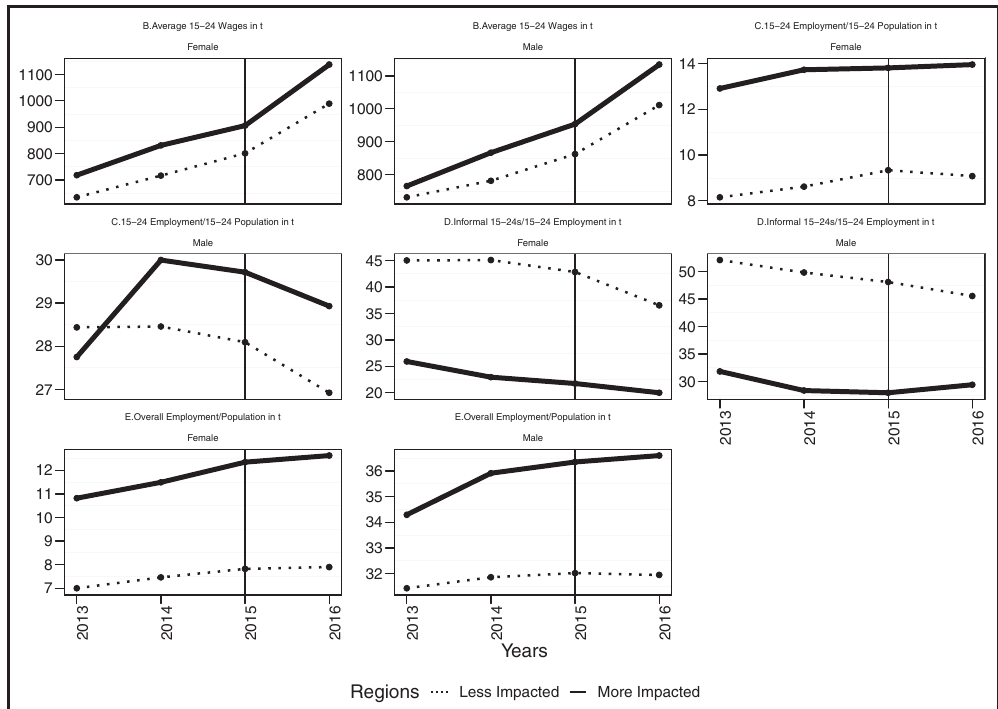
Testing parallel trend assumption: Labor market outcomes of young (15–24) workers during the period of